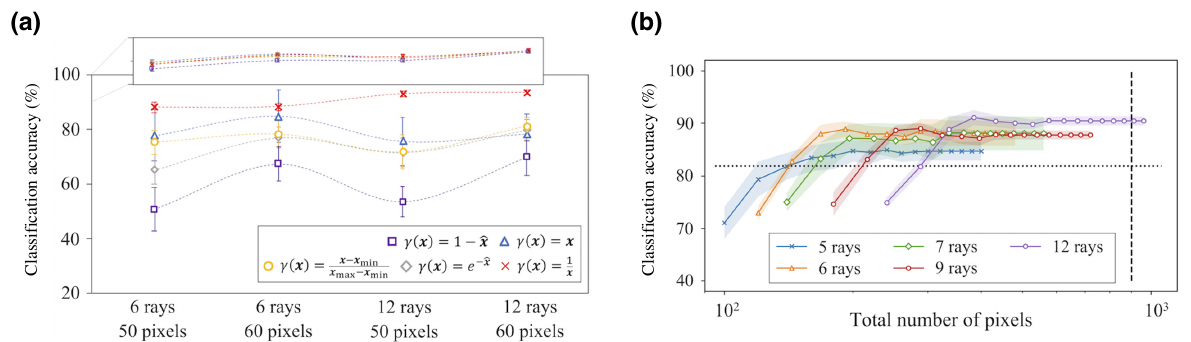
FIG. 2. (a) Classifier performance for various weight functions γ ( x ) and for different numbers of rays and ray lengths using off-line experimental data (averaged over N = 20 models). The inset at the top shows the performance on simulated data. (b) Classifier perfor- mance for different numbers of rays as a function of the total number of pixels measured for off-line experimental data (averaged over N = 20 models). The dotted black horizontal line represents the benchmark from Ref. [21], while the dashed vertical line represents the minimum data requirement for a CNN classifier as used in Ref. [21]. In both panels, the connecting lines are a guide for the eye only. The error bars (a) and bands (b) correspond to one standard deviation.